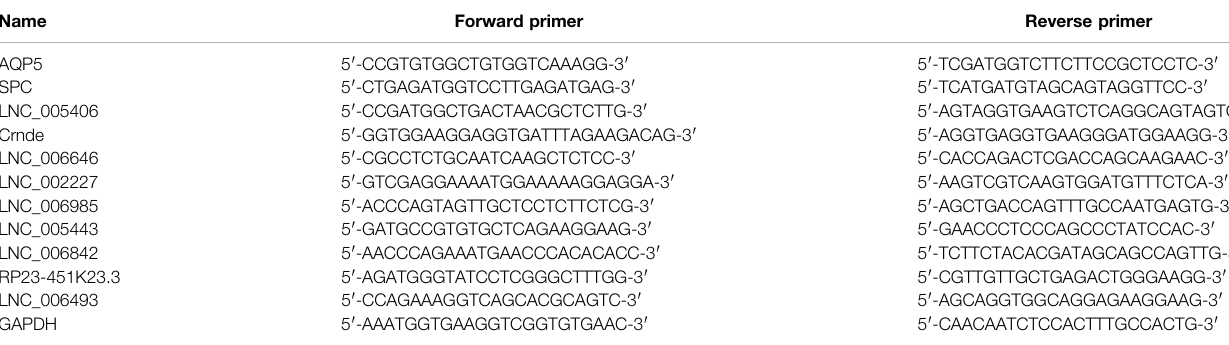
TABLE 1 | The speci fi c description of the primer